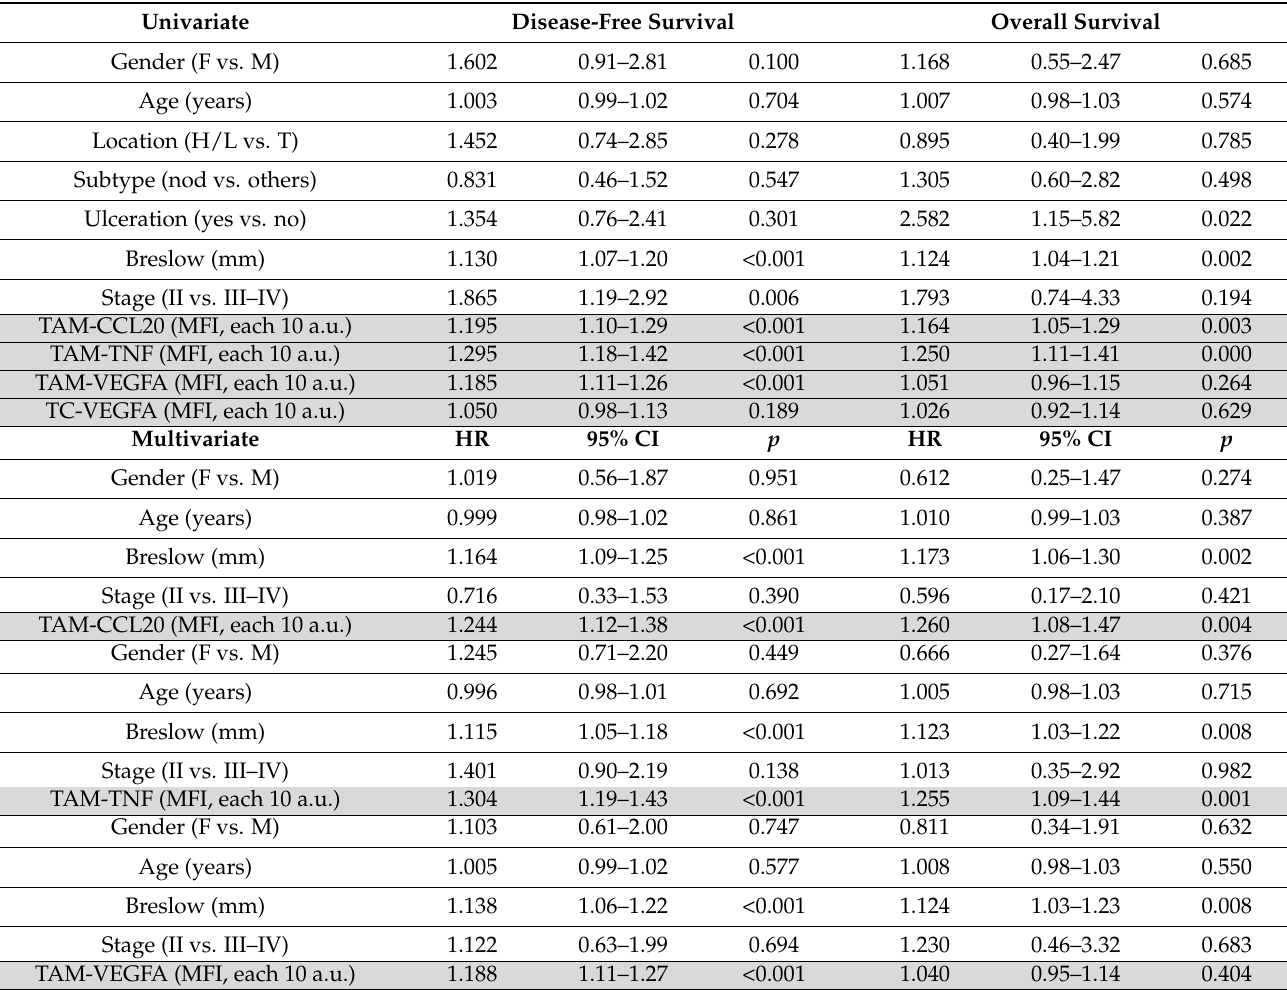
Table 1. Univariate and multivariate Cox regression analyses for 10-year disease-free and overall survival (FFPE cohort). Univariate Disease-Free